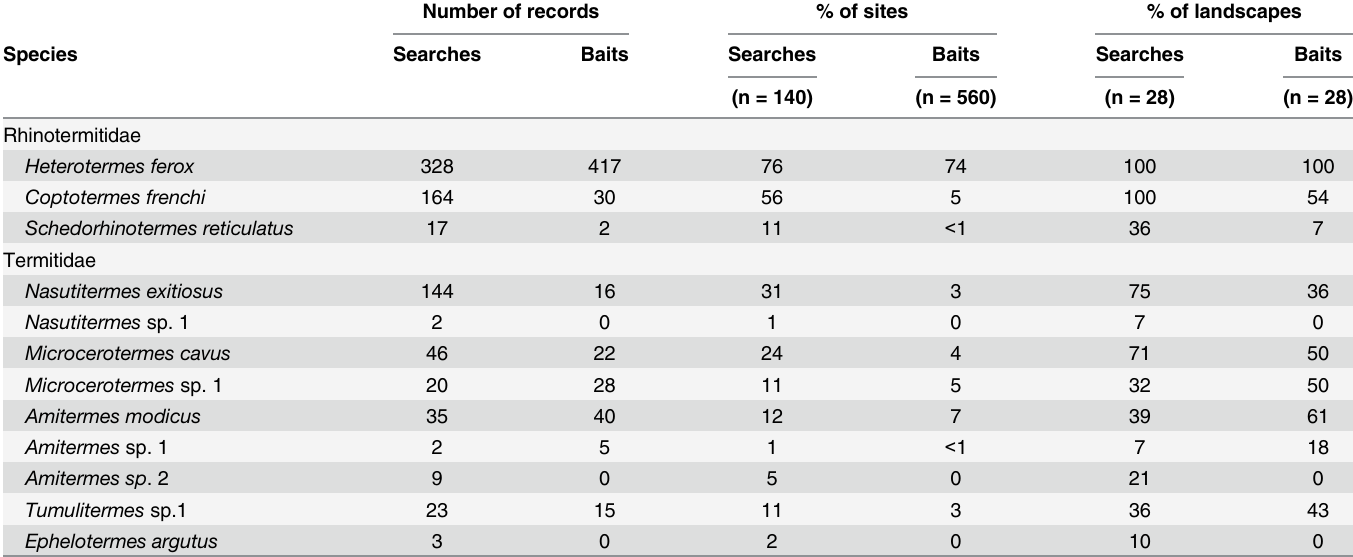
Table 2. Species of termite found in mallee vegetation by using baits and active searches; the number of records (searches: encounters of ter- mites, baits: presence on grid of six baits), and the percentage of sites and landscapes in which each species was found.